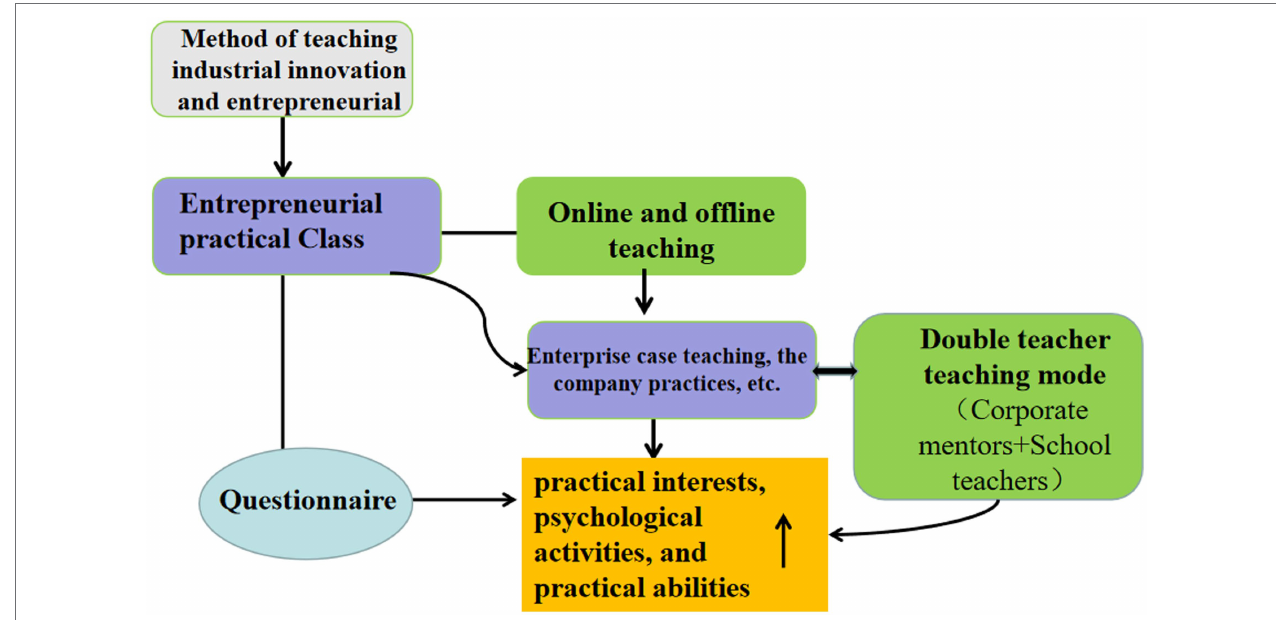
FIGURE 1 | The relationship between the entrepreneurial interest of biology major students in and college teaching.